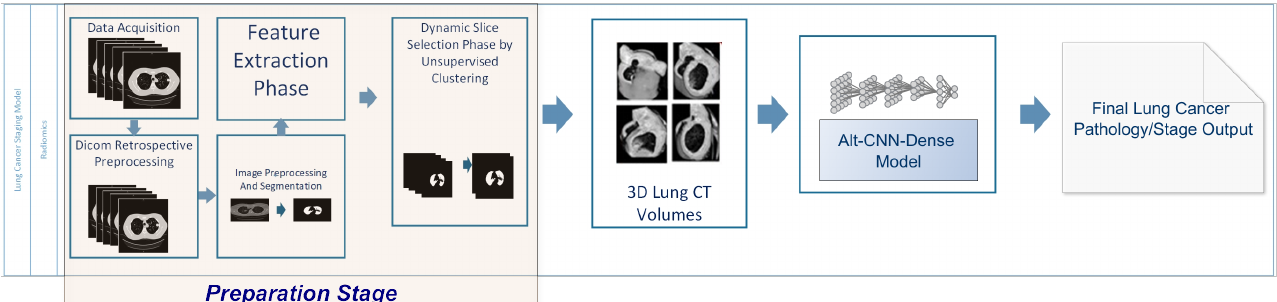
Figure 2. DETECT-LC multistage computational model for lung cancer pathology subtype or stage